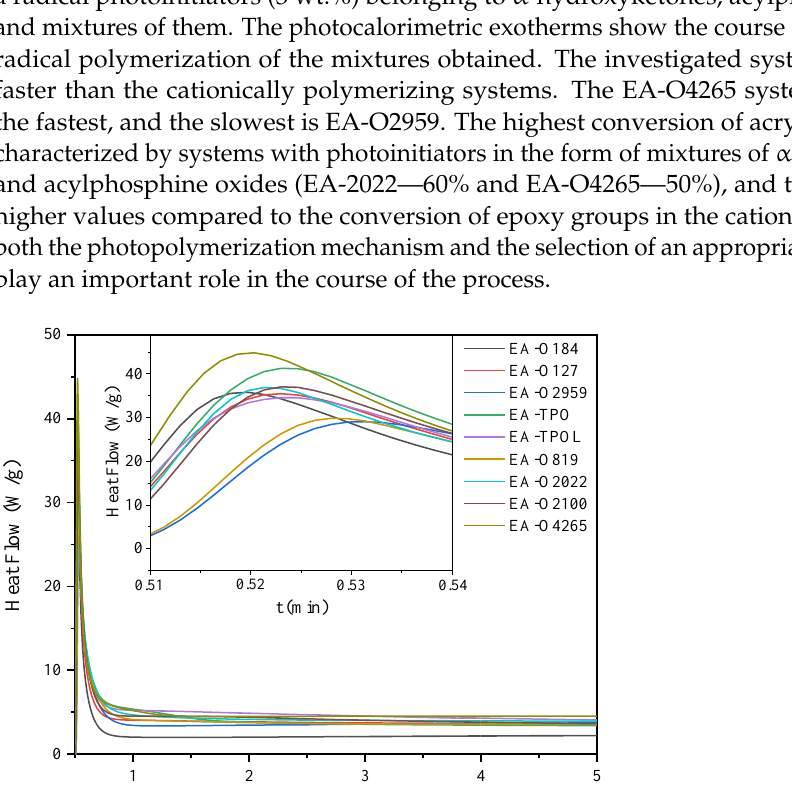
Figure 13. The acrylate conversion and photopolymerization rate curves of the epoxy acrylate for- mulations with radical photoinitiators. In order to determine the effect of the type (cationic or radical) and the course of photopolymerization of systems with different photoinitiators, the basic properties of the